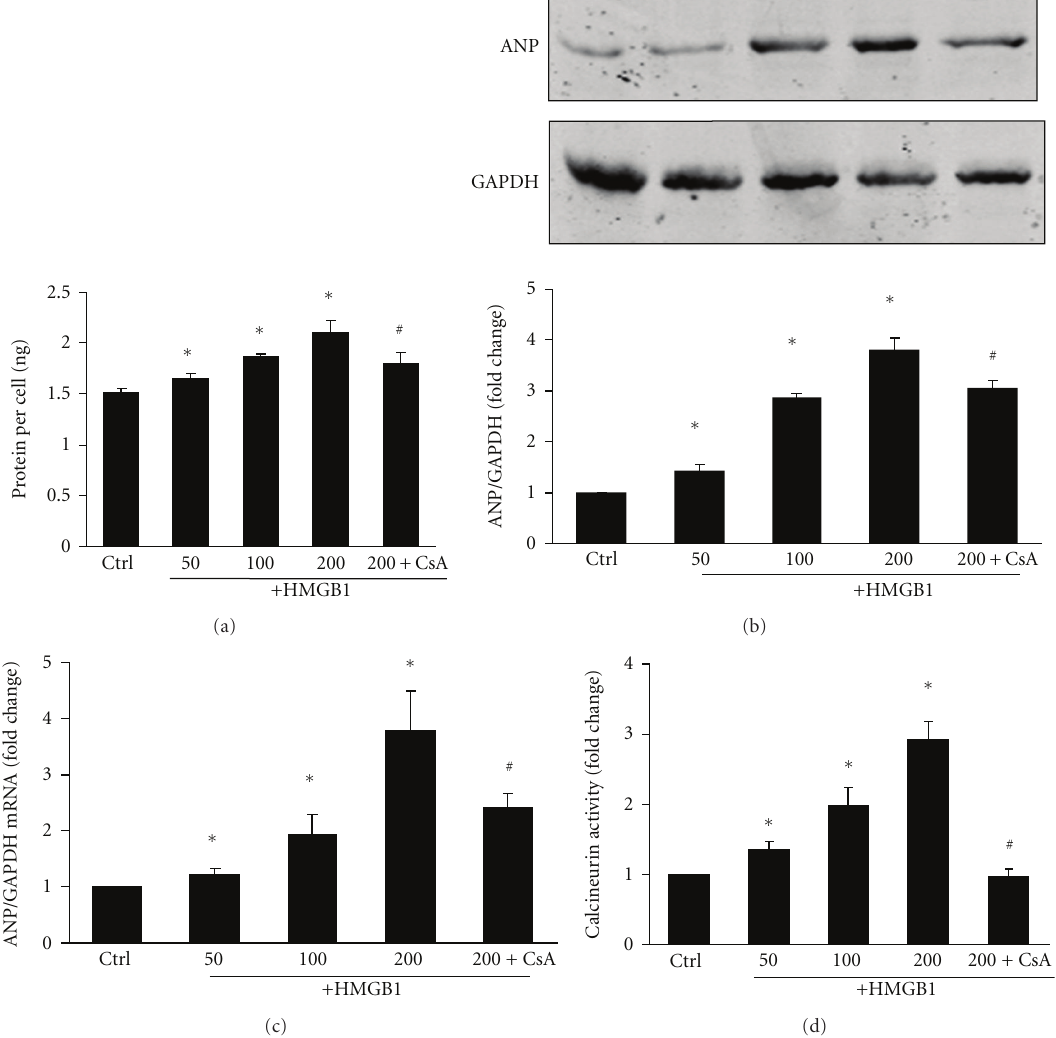
Figure 3: E ff ect of CsA on NRVMs pretreated with HMGB1. CsA (1 μ M) was applied for 1h prior to a 200 ng/mL HMGB1 challenge in NRVMs. (a) NRVM protein synthesis was determined by protein content per cell. (b) Expression of ANP protein in NRVMs was determined by Western blot analysis; the integrated optical density (IOD) of ANP expression bands was analyzed. (c) Expression of ANP mRNA in NRVMs was determined by real-time RT-PCR. (d) Calcineurin activity was determined by a calcineurin assay kit. The bar graph represents three independent experiments. ∗ P < 0 . 05 versus control. # P < 0 . 05 versus 200ng/mL HMGB1 treated group. Ctrl: control group; CsA: cyclosporin